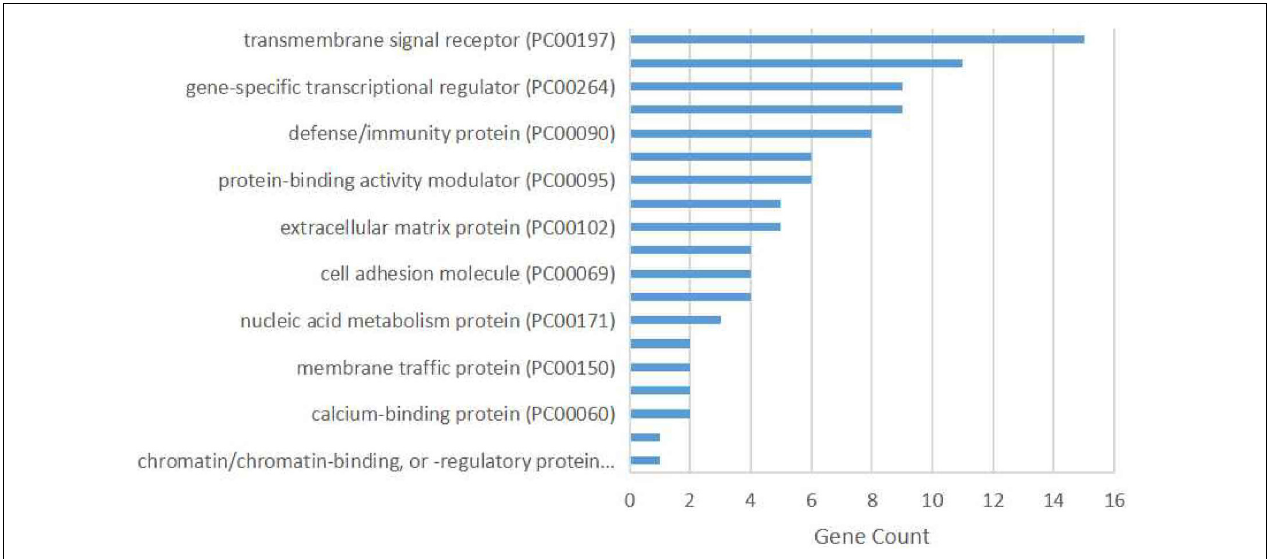
FIGURE 3 | Protein class over-representation of proteins encoded by the overlapping differentially expressed genes identified using the PANTHER database.